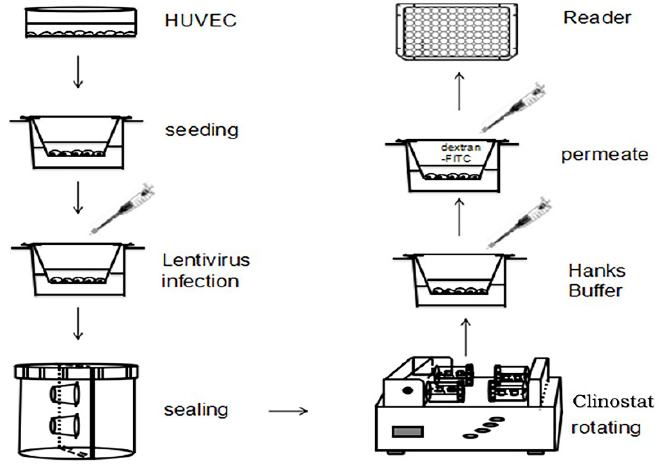
Figure 1. Establishment of monolayer cell permeability model under SMG.